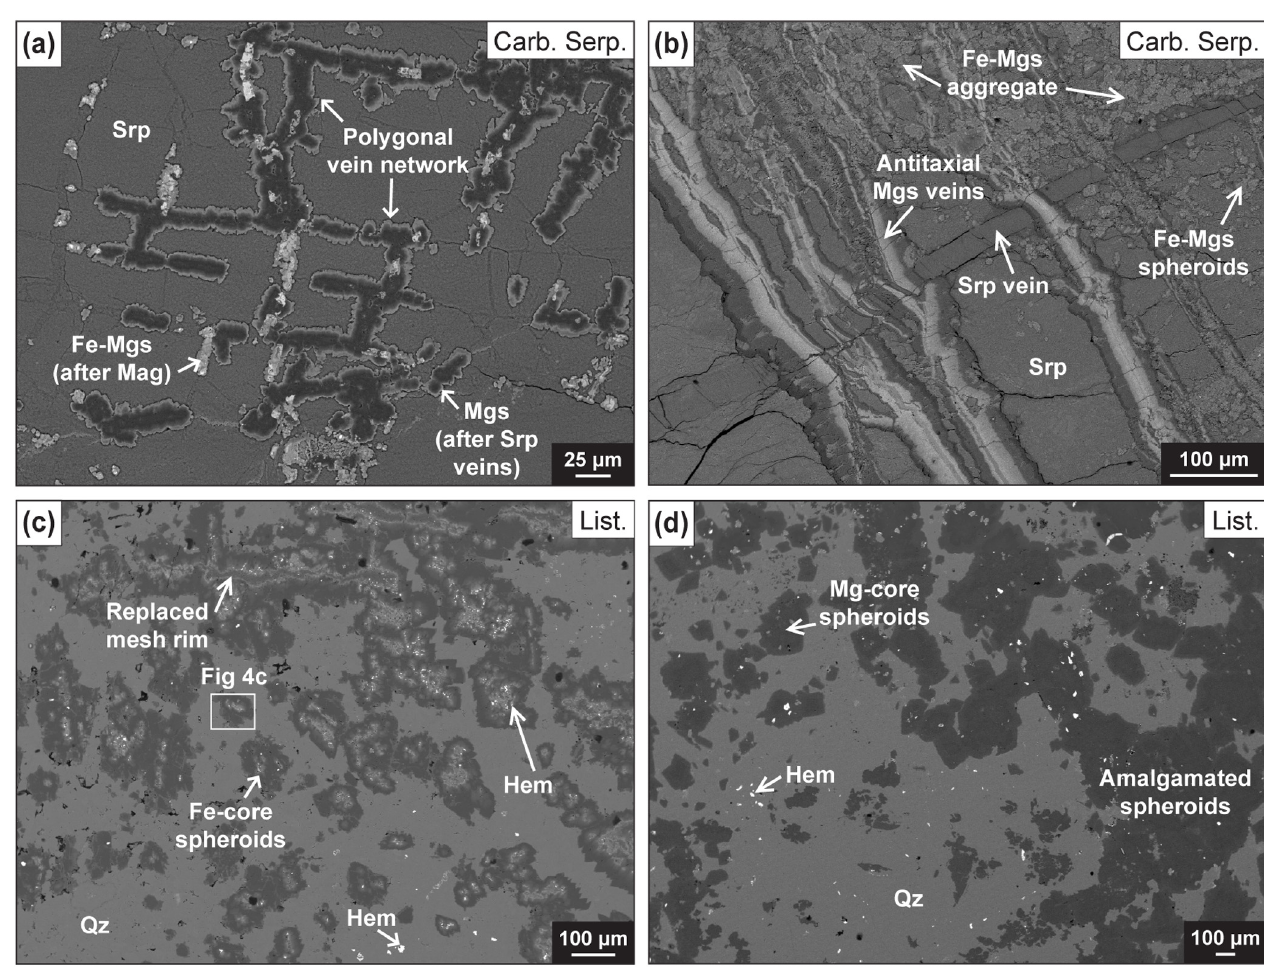
Figure 3. Backscattered electron (BSE) images of carbonate microstructures and textures representative of reaction Stage 1 (a–c) and Stage 2 (d) . (a) Magnesite replacing serpentine mesh rims in characteristic polygonal vein networks in carbonated serpentinite 44Z-2-47-50. (b) Crack-seal serpentine vein cut by antitaxial magnesite veins showing an Fe-rich median zone (light grey) and Mg-rich vein walls (dark grey) in carbonated serpentinite 44Z-4-0-5. Fe-rich magnesite spheroids and aggregates formed in the vicinity of antitaxial veins. (c) Fe-core spheroids (light grey cores) that developed in the vicinity of a former mesh rim preserved in listvenite 50Z-1-75-80. (d) Mg-core spheroids locally amalgamated to form aggregates in listvenite 46Z-4-46-51. Abbreviations: Hem: hematite; Mag: magnetite; Mgs: magnesite; Qz: quartz; Srp: